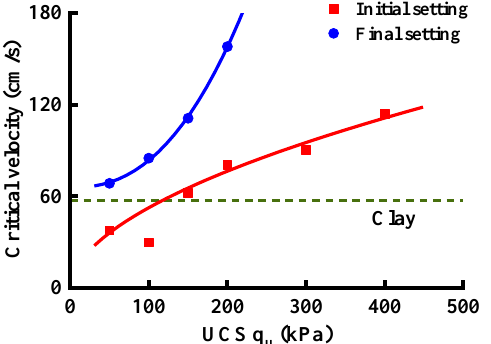
Figure 17. Relationship between the UCS and the critical flow velocity.